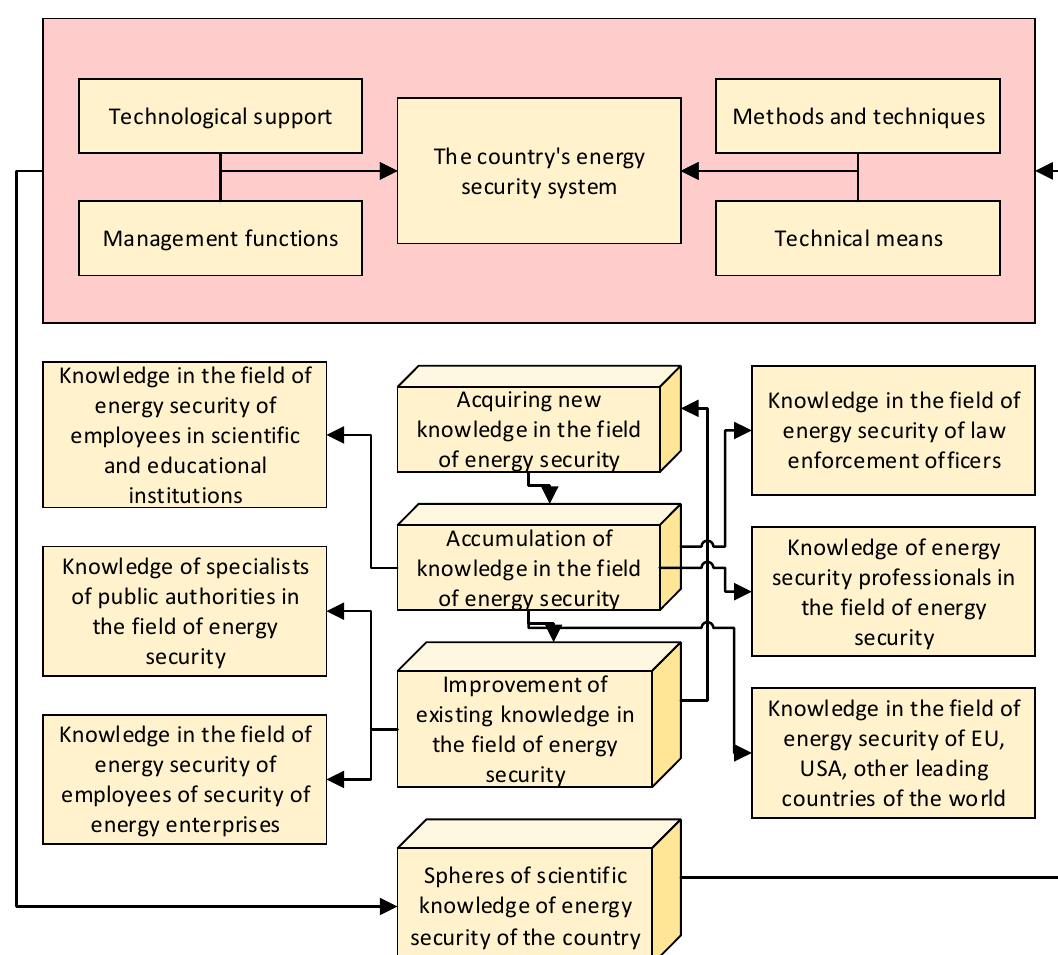
Fig. 2: System of knowledge management in the field of energy security of the country